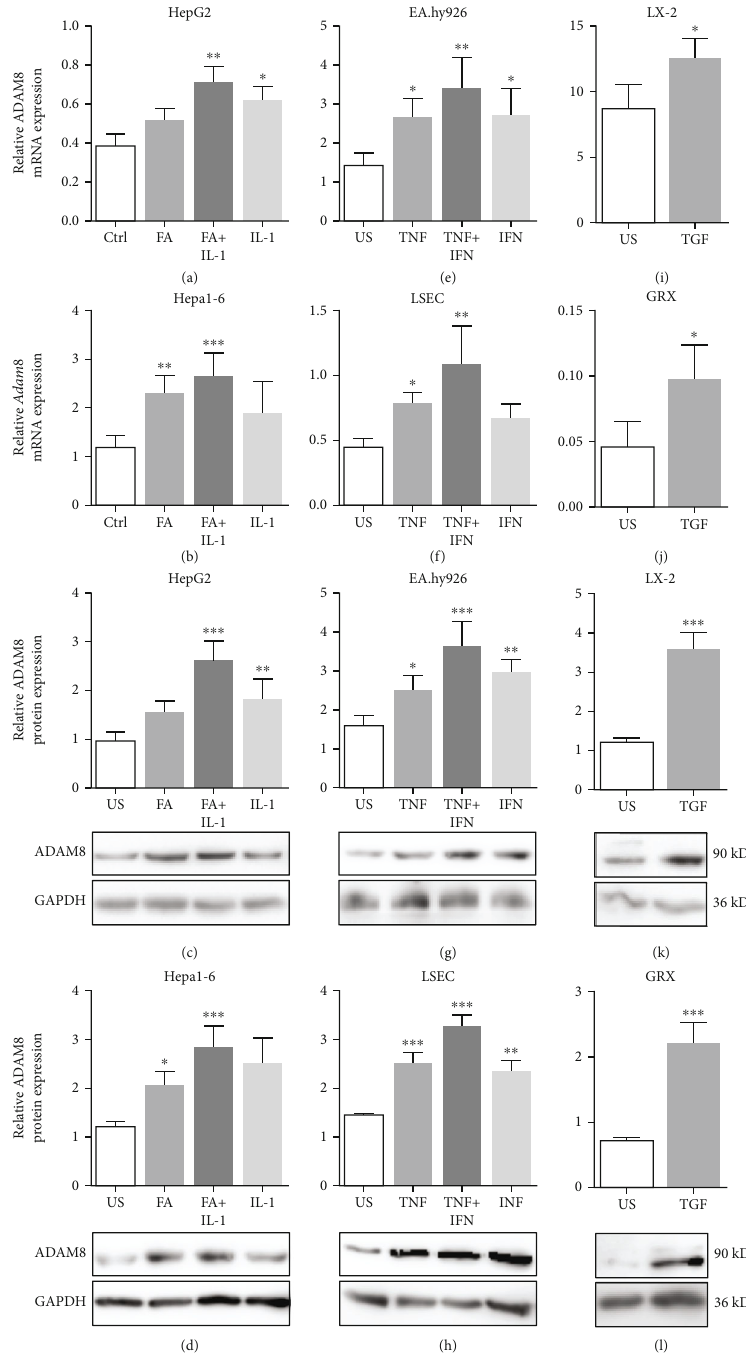
Figure 6: ADAM8 upregulation in cultured liver cells by mediators of steatohepatitis. (a – d) Murine Hepa1-6 and human HepG2 hepatoma cells were either left unstimulated (US) or stimulated with fatty acid (FA), IL-1 β , or a combination of both. After 24 h, the cells were analysed for ADAM8 mRNA expression(a, b) and protein expression (c, d). (e – h) Murine LSEC and human EA.hy926 endothelial cells were left unstimulated (US) or stimulated with TNF- α , IFN- γ , or a combination of both (TI). After 24 h, the cells were analysed for ADAM8 mRNA (e, f) and protein expression (g, h). (i – l) Murine GRX and human LX-2 stellate cells were left unstimulated (US) or stimulated with TGF- β . After 24h, the cells were analysed for ADAM8 mRNA (i, j) and protein expression (k, l). The mRNA expression was analysed by qPCR and normalised to Rps29 for murine cells and to GAPDH for human cell lines. The protein expression was analysed by Western blot, and representative blots are shown for each cell line. The protein expression was quanti fi ed by densitometry and normalised to GAPDH. Quantitative data are shown as the mean + SD of 3-4 independent experiments. Signi fi cant di ff erences to the unstimulated controls are indicated by asterisks ( ∗ p < 0 : 05 , ∗∗ p < 0 : 01 , and ∗∗∗ p < 0 : 001